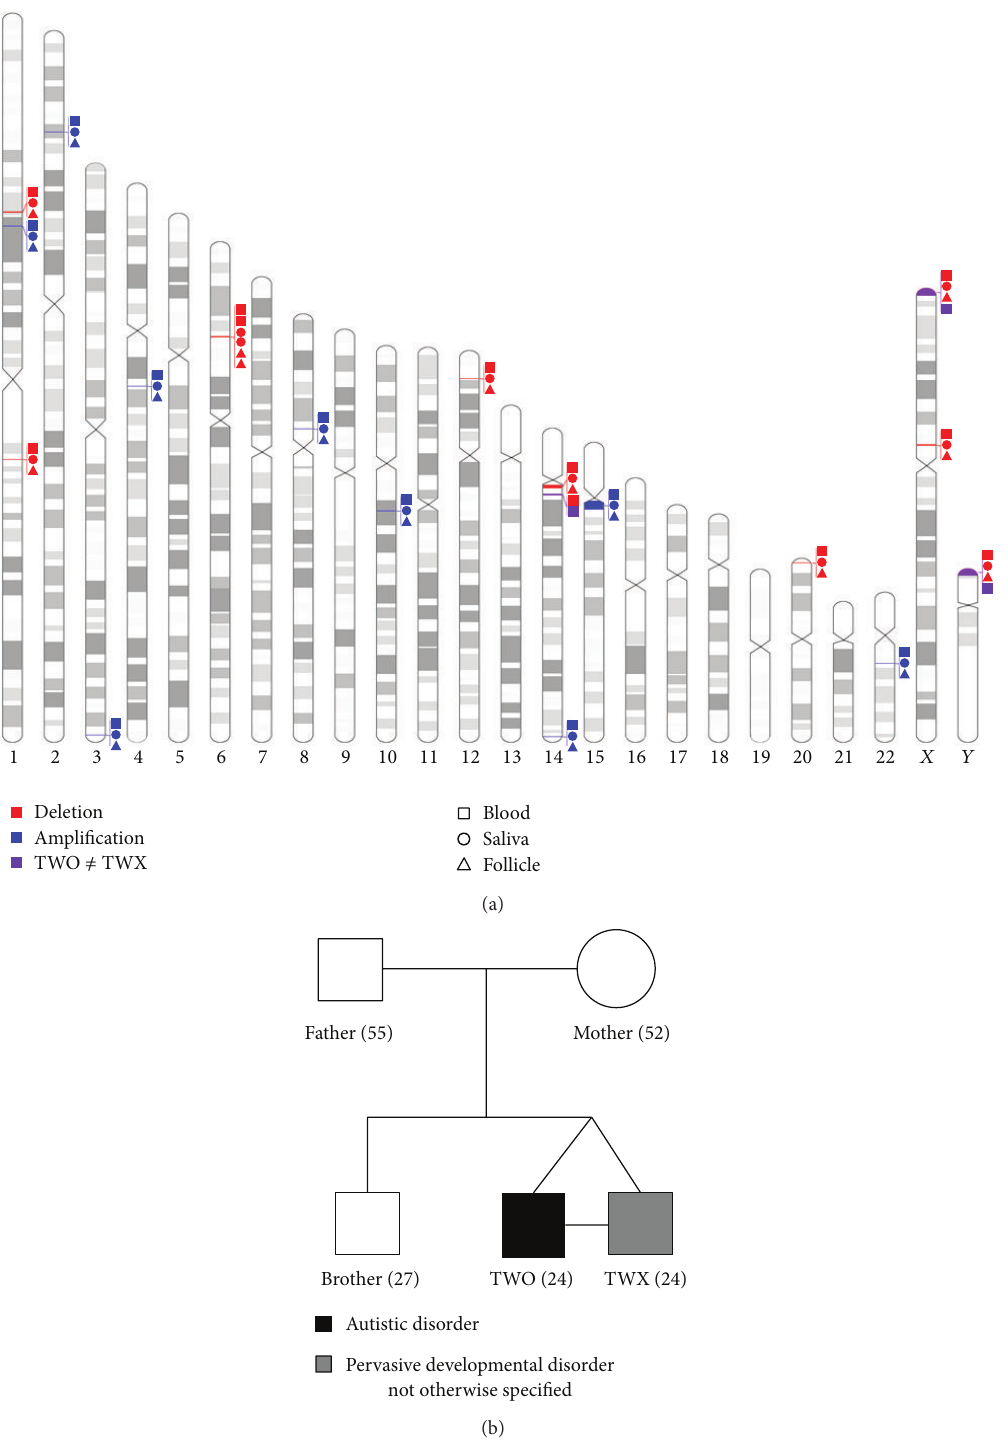
Figure 1: (a) Summary of copy number variant regions identified in this study plotted using Idiographica web server [10]. (b) Family pedigree of cases